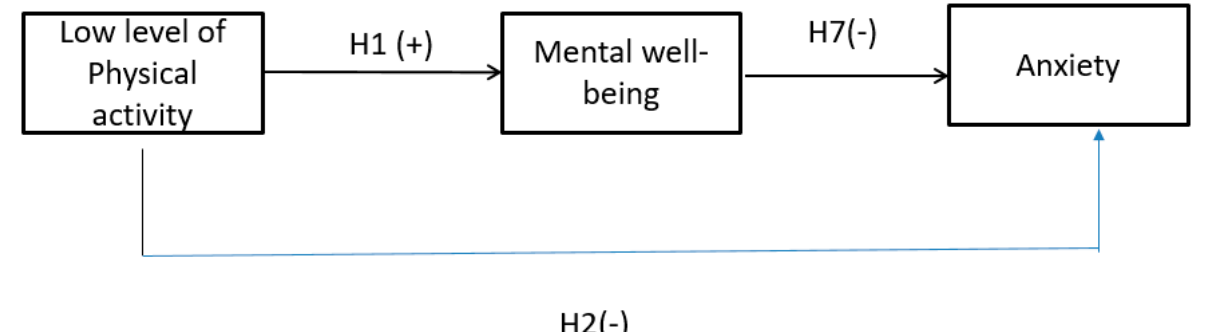
Figure 4. Full mediation effect. Note: H means hypothesis; + sign means positive association; and - sign means negative association.